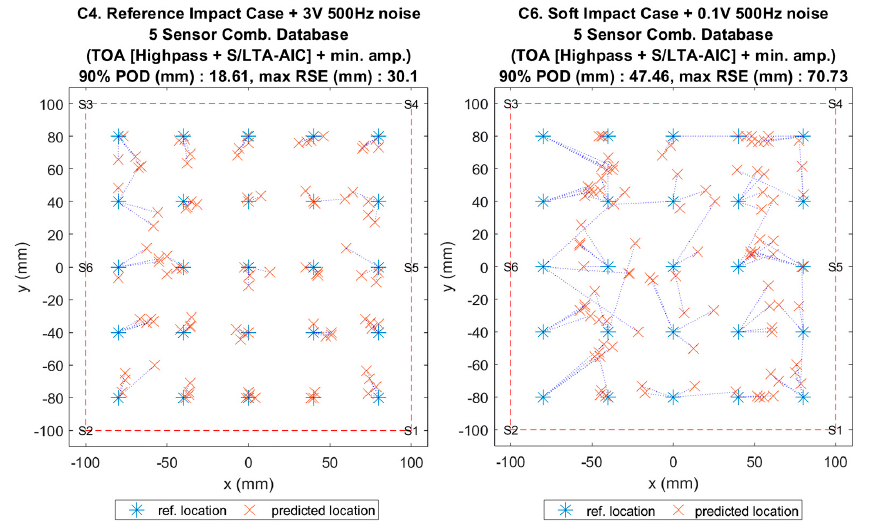
Figure 15. Visualisation of impact localisation for impacts with added noise for hard (F7, left) and soft (F9, right) impacts on the flat plate.